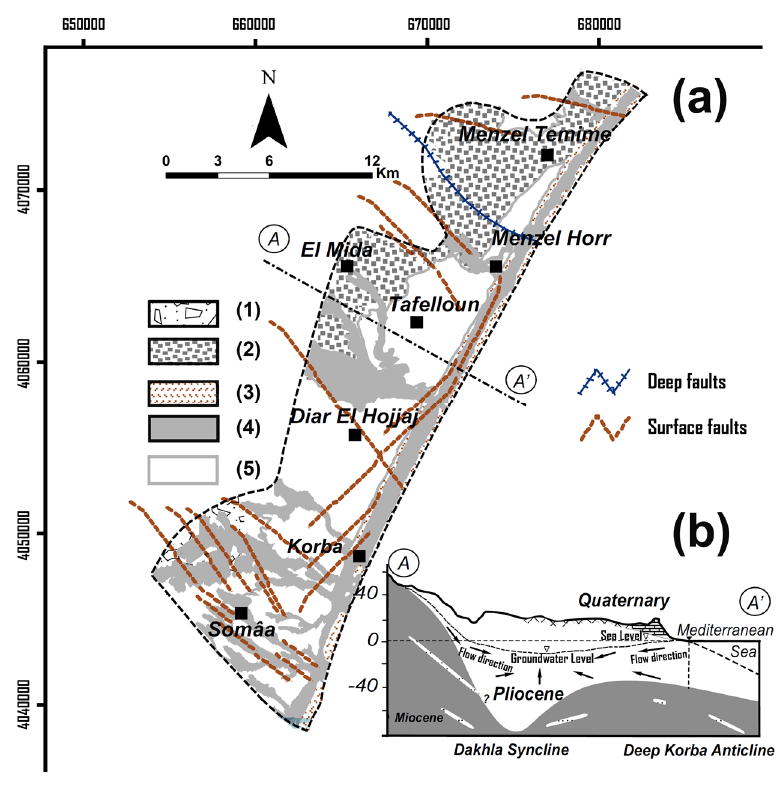
Figure 2. ( a ) Geologic and structures map of the Korba aquifer: ((1) Miocene sands, (2) Pliocene sands, (3) Tyrrhenian sandstones, (4) Quaternary alluvial deposits, (5) Marine Quaternary) and ( b ) Schematic cross section of the aquifer showing the subsurface hydro-geological and groundwater flow movements [2].